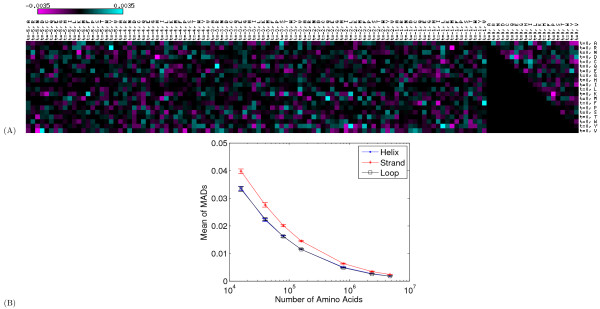
Comparison of learned and true dlink values. (A) The figure depicts the difference between the dlink values learned from real data and synthetic data with 30,000 proteins for helices at 20% sparsity level (see Figure 4(A) for a more detailed representation of this result). (B) The figure plots, as a function of training set size, the mean of the MAD metric (see text) computed across ten replicate experiments with 20% sparsity. The three series correspond to the helix, strand, and loop graphs. Error bars correspond to standard deviations. Both figures demonstrate that the model parameters learned from synthetic data are close to the parameters learned from real data. This shows that when the data is generated from a sparse model (i.e., the true model we are trying to recover is sparse) the sparsity algorithm proposed in this paper is able to learn these parameters correctly.